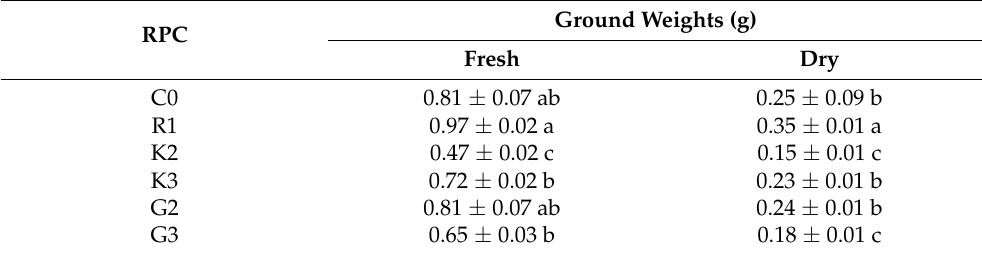
In columns, different letters indicate significant differences within parameters (S.N.K. test, p ≤ 0.05; mean ± SD, n = 3) C0: untreated control; R1: Rhizopon AA (1% IBA); K: Kelpak ® ; G: Goteo ® ; K2: 2 mL L − 1 ; K3: 3 mL L − 1 ;